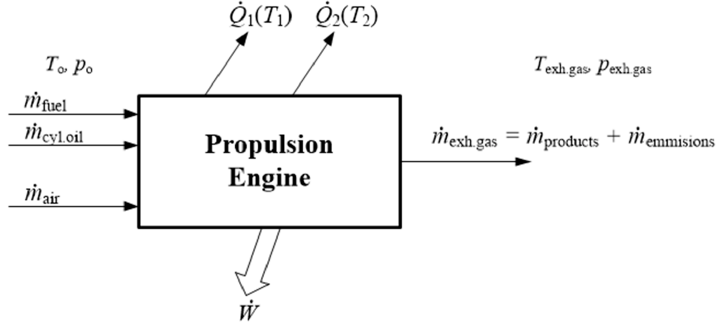
Figure 1. The propulsion engine model depicting main input and output substances and energy flows.